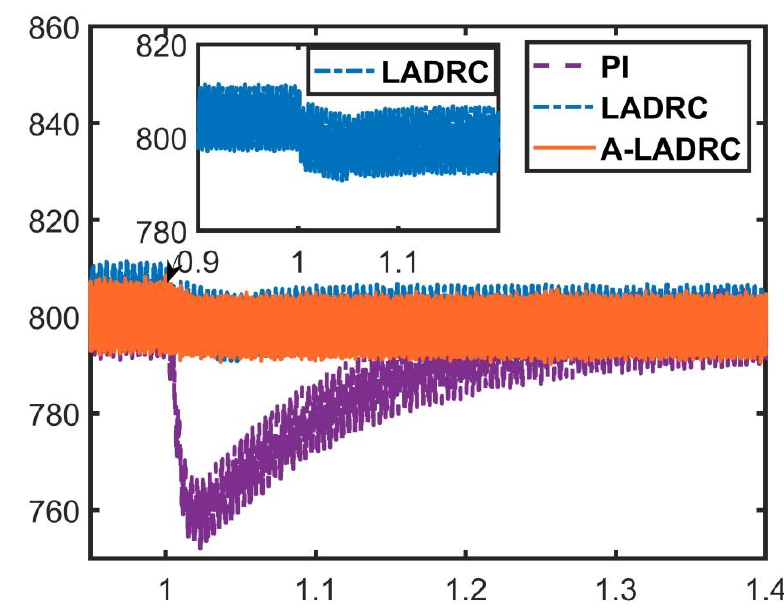
Figure 15. DC bus voltage waveform during fault recovery.